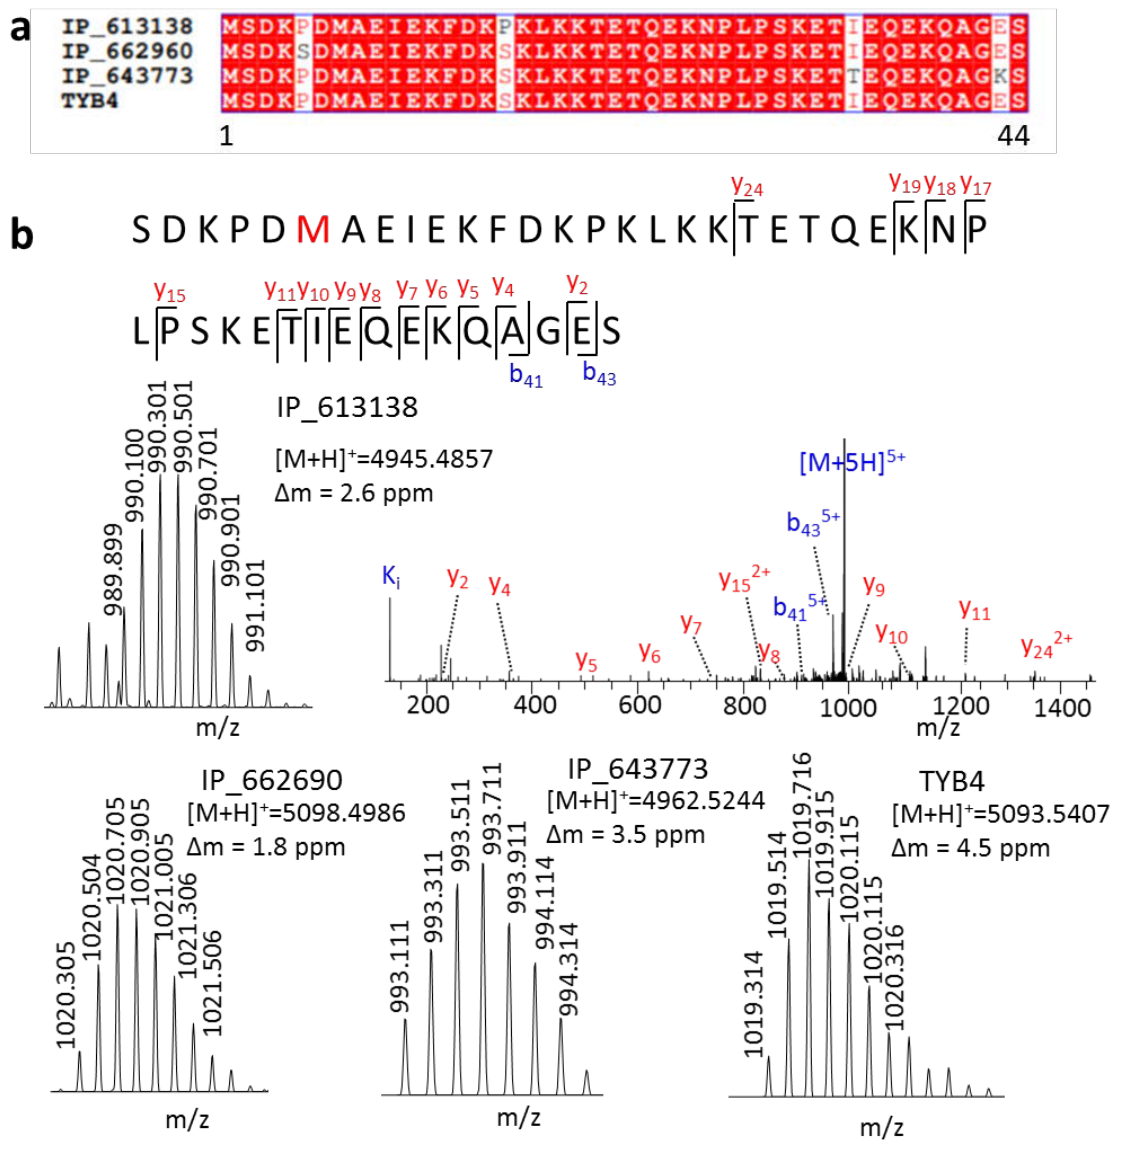
Figure 3. Distinct highly similar peptides by a top-down approach. ( a ) Sequence alignment of peptides IP_613138, IP_662690, IP_643773, and TYB4, and ( b ) their spectra.